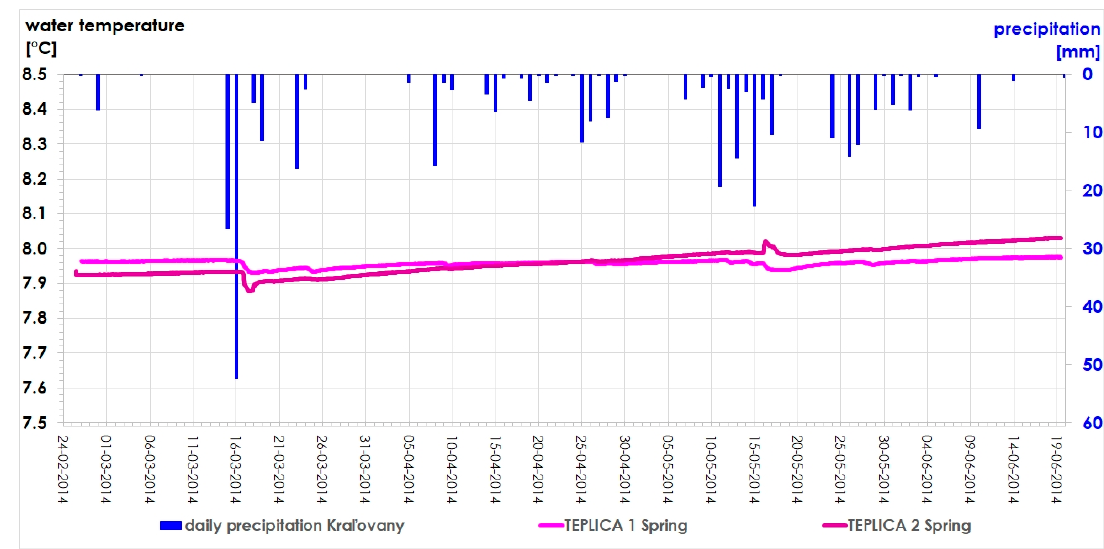
Figure 11. Daily precipitation in Kra ľ ovany and groundwater temperatures in the Teplica 1 and Teplica 2 Springs—impact of 15.03.2014–16.03.2014 precipitation event more visible in the case of Teplica 2 Spring.